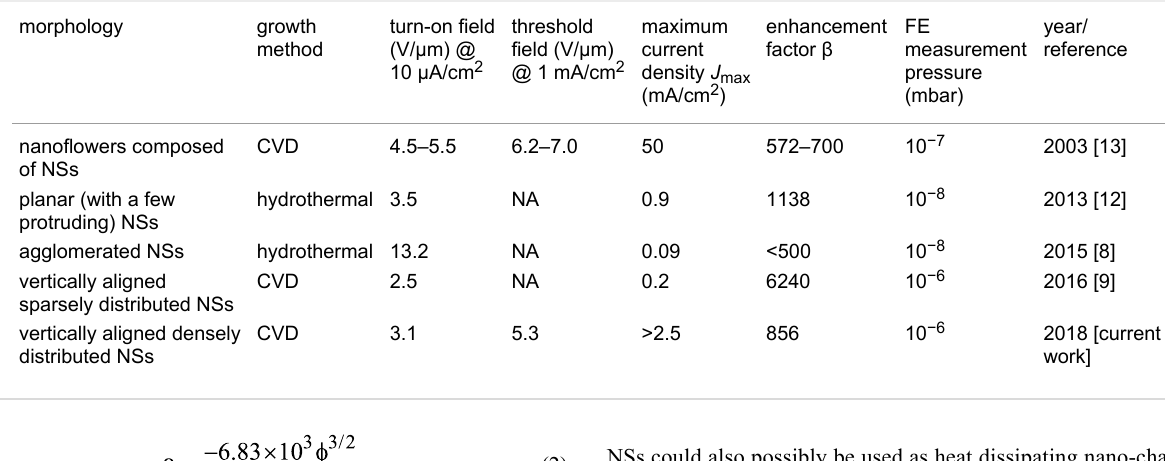
Table 1: Comparison of field-emission properties of MoS 2 nanosheets (NSs) produced using different methods. morphology